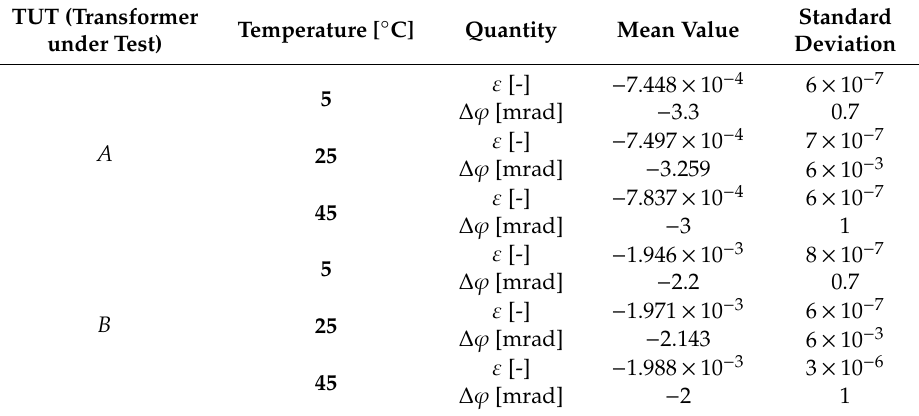
Table 4. Measured ratio and phase error obtained in [11] and used as a reference for this study. TUT